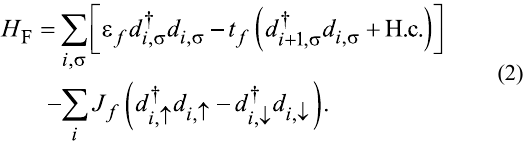
Since we focus on the effects of the interactions in the organic ferromagnet on transport, we model the electrodes by simple one-dimensional chains described by a single-band tight- binding model with a spin-splitting term [34],